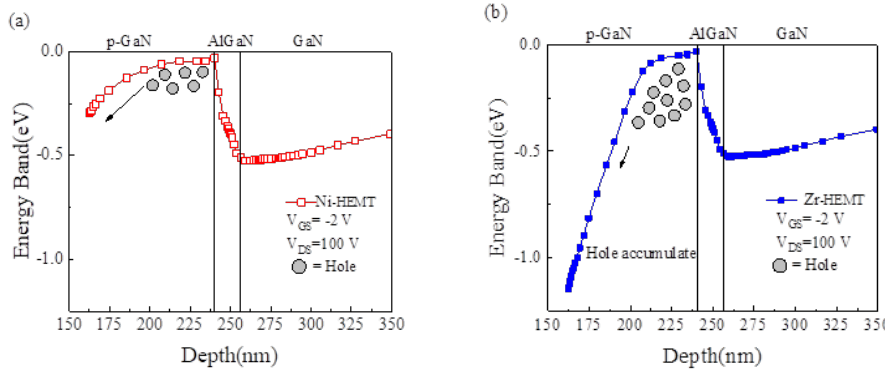
Figure 4. Valence band of ( a ) Ni and ( b ) Zr contact to p-GaN are simulated by TCAD.